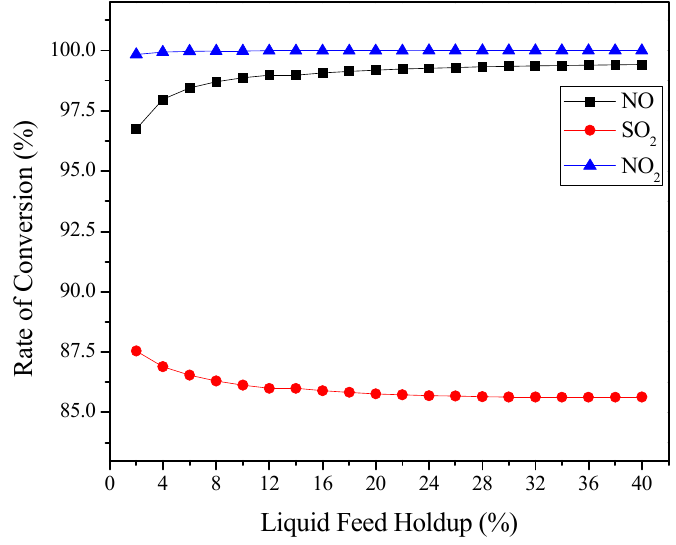
Figure 11. E ff ect of Feed holdup on Rate of Conversion Figure 11. Effect of Feed holdup on Rate of Conversion (%).